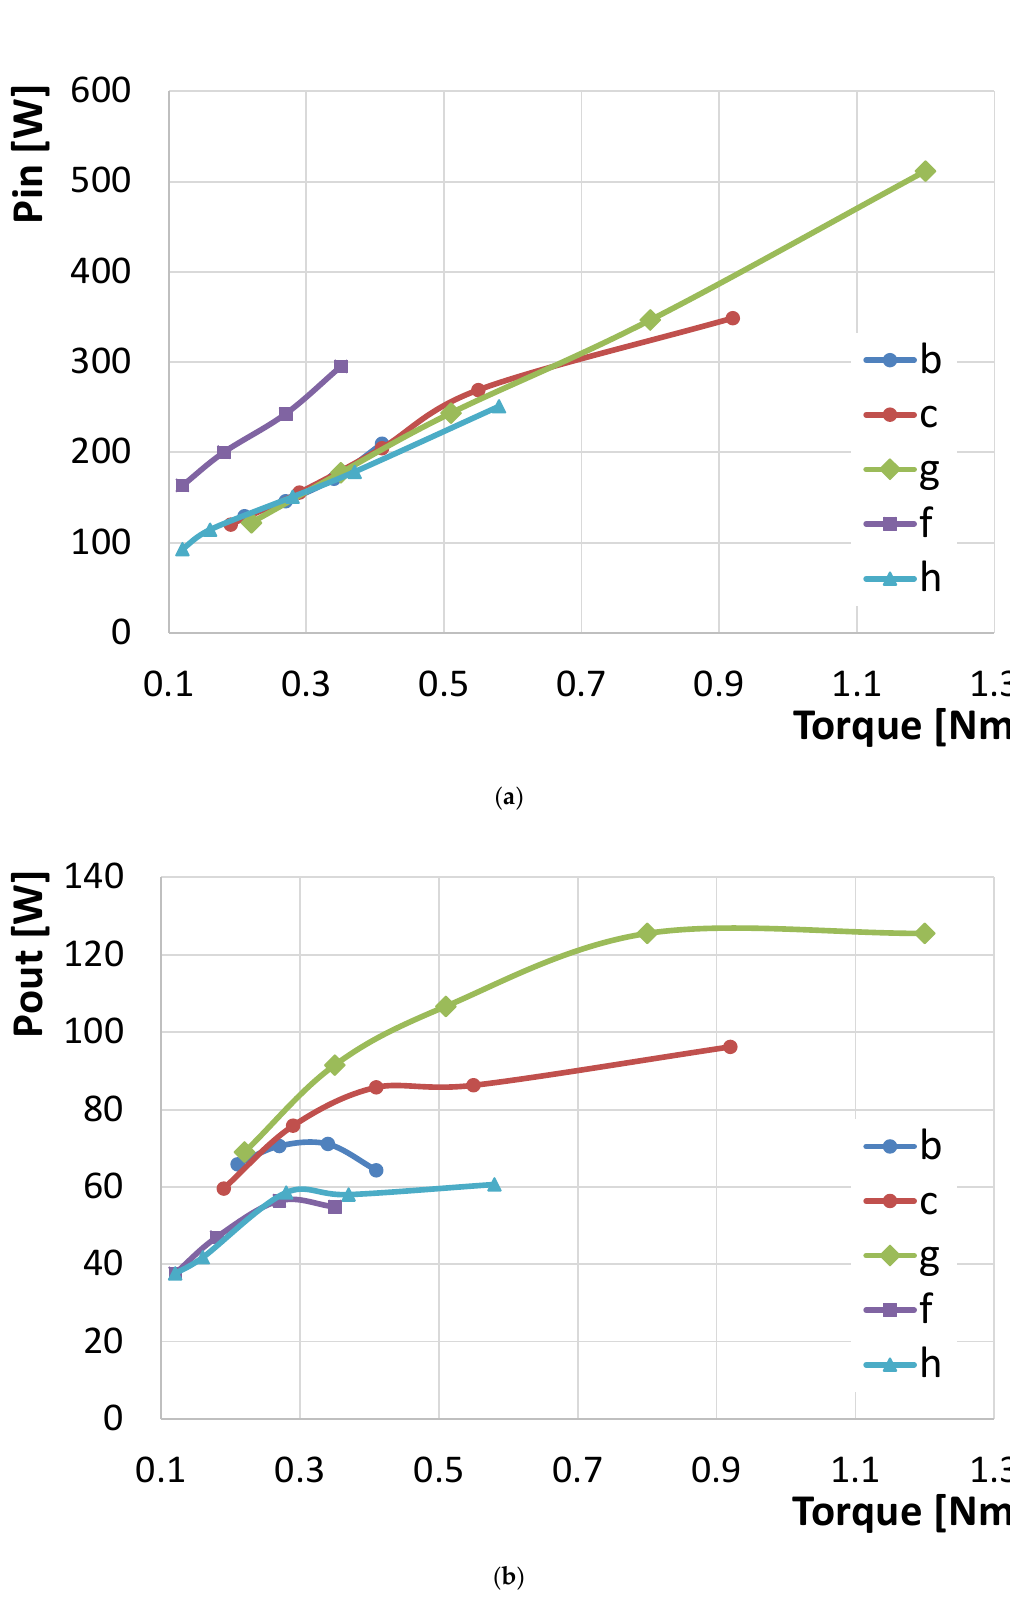
Figure 12. Input ( a ) and output ( b ) power vs. torque dependencies of the winding interconnections defined in Figure 6. Since the experimental setup suffered from an initial inertial load in the form of the rotor and clutch of the dynamometer, while the BLDC motor control was performed on